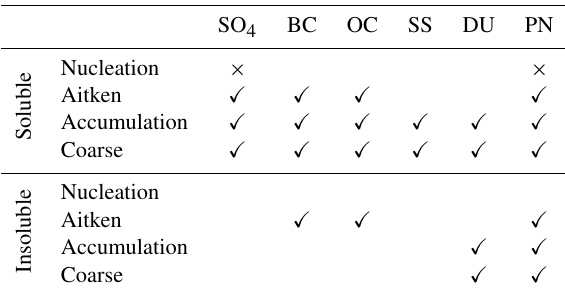
Table 1. State vector of the assimilation system composed by the mass mixing ratio of all the modes and species and number mixing ratio (PN) for all modes in ECHAM-HAM. Aerosols in nucleation mode are not considered in the assimilation since they contribute a very small fraction in the optical depth of